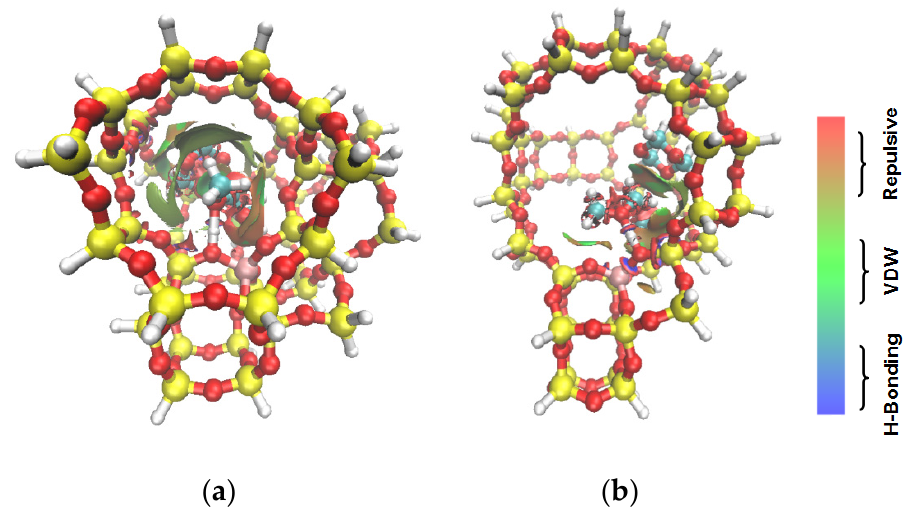
Figure 5. Isosurface plots of the reduced density gradient (s = 0.500 a.u.) for the coadsorption of DMM and TOM in ZSM-5 ( a ) and USY ( b ). The isosurfaces of the reduced density gradient are colored according to the values of the quantity sign ( λ 2) ρ , as indicated by the RGB scale. VDW: van der Waals interactions.